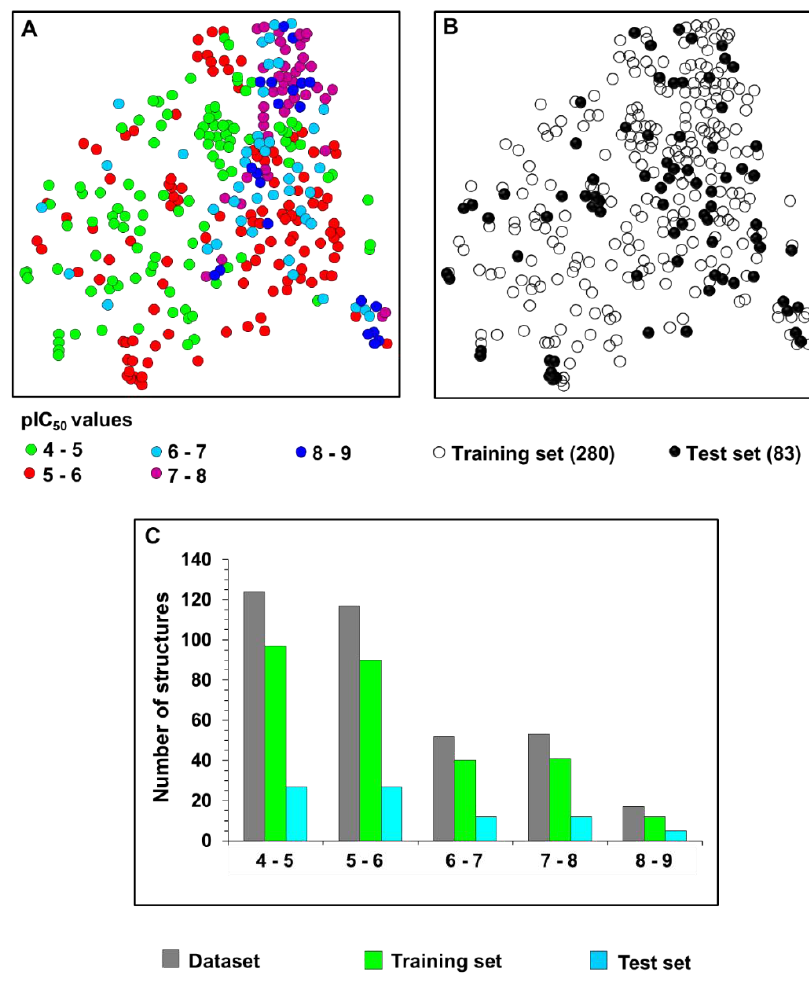
Figure 2. Structural and activity landscape of the dataset. ( A ) Structure similarity map for the entire dataset composed of 363 compounds, which shows its broad chemical diversity and activity range. ( B ) Structure similarity map highlighting the training (open circles) and test set (solid circles) compounds. ( C ) Activity distribution for the whole dataset and for the training and test sets.